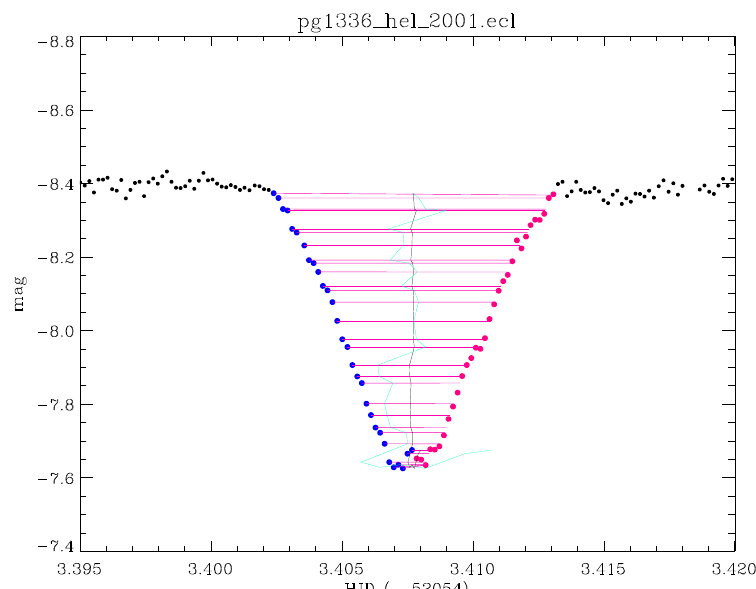
Fig. 1. An eclipse of PG 1336 − 018 observed at Catania (dots) with its bisector superimposed.